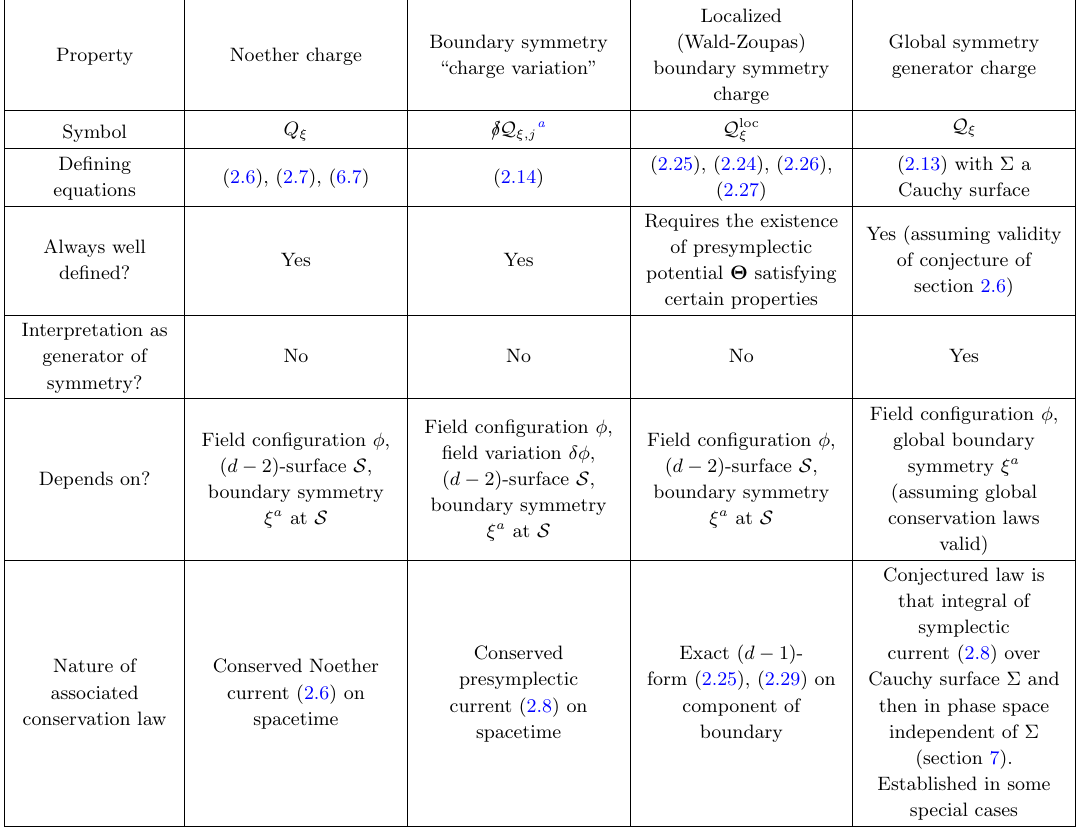
Table 1. A summary of the properties of the various charges and conservation laws reviewed in this